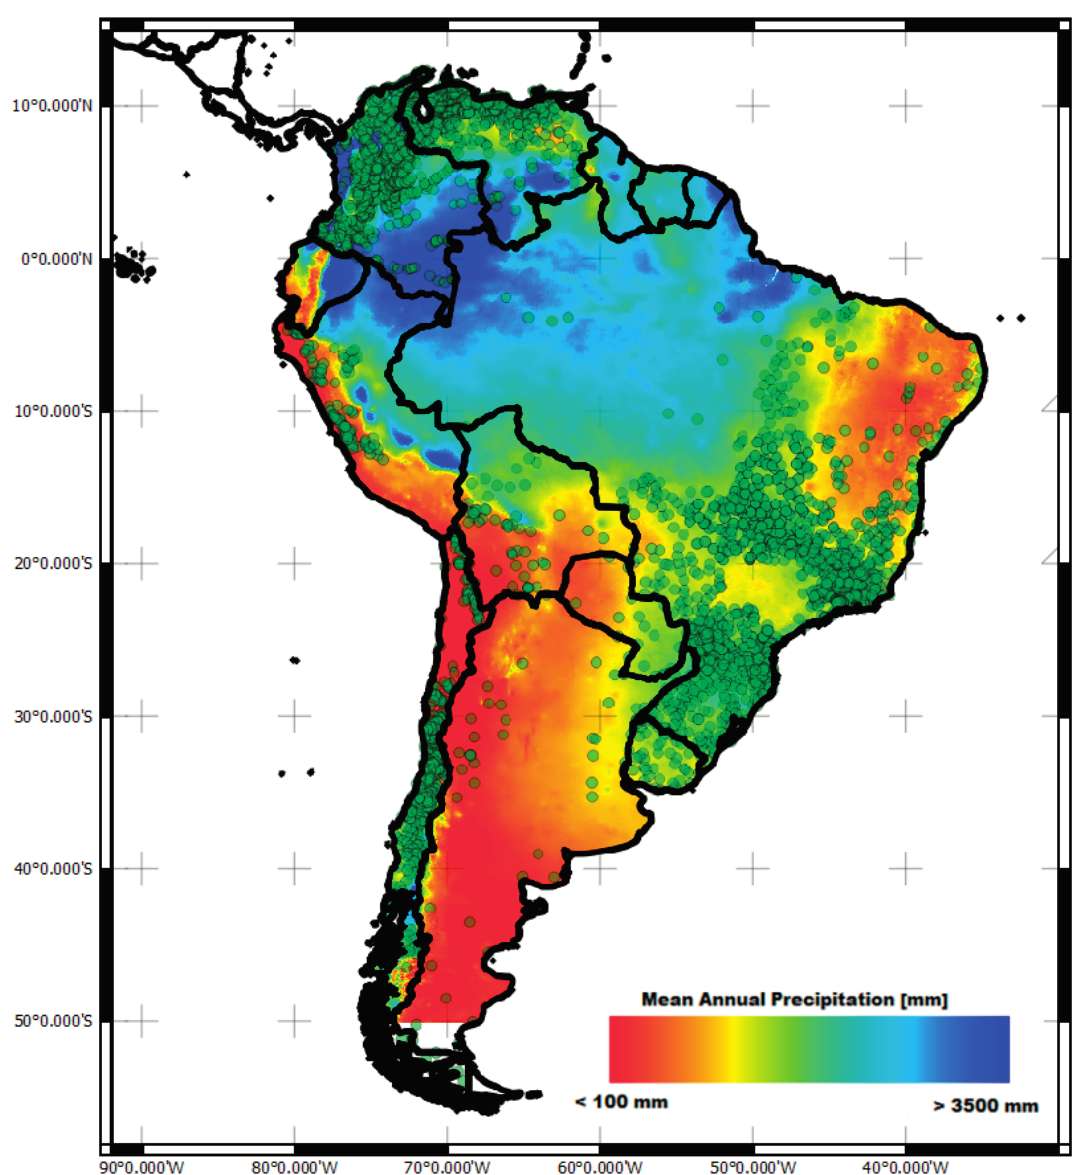
Figure 5 ． Mean Annual Precipitation across South America using the CHIRP dataset. Green points represent the rain gauge stations against with the high resolution MAP product has been